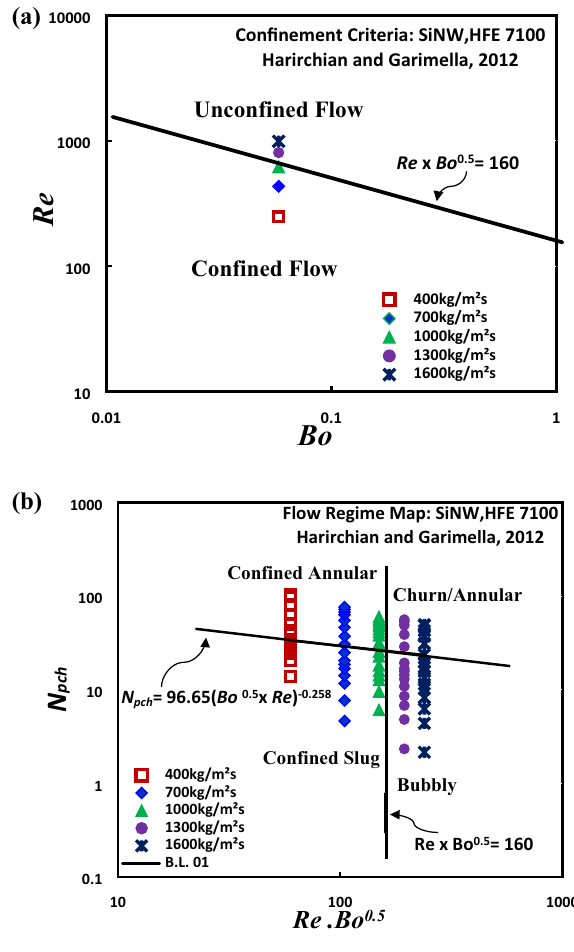
Figure 13. ( a ) Vapor confinement criteria at different mass fluxes of HFE 7100 and ( b ) Harirchian and Garimella 34, 35 flow regime map for SiNW at different mass fluxes of HFE-7100.